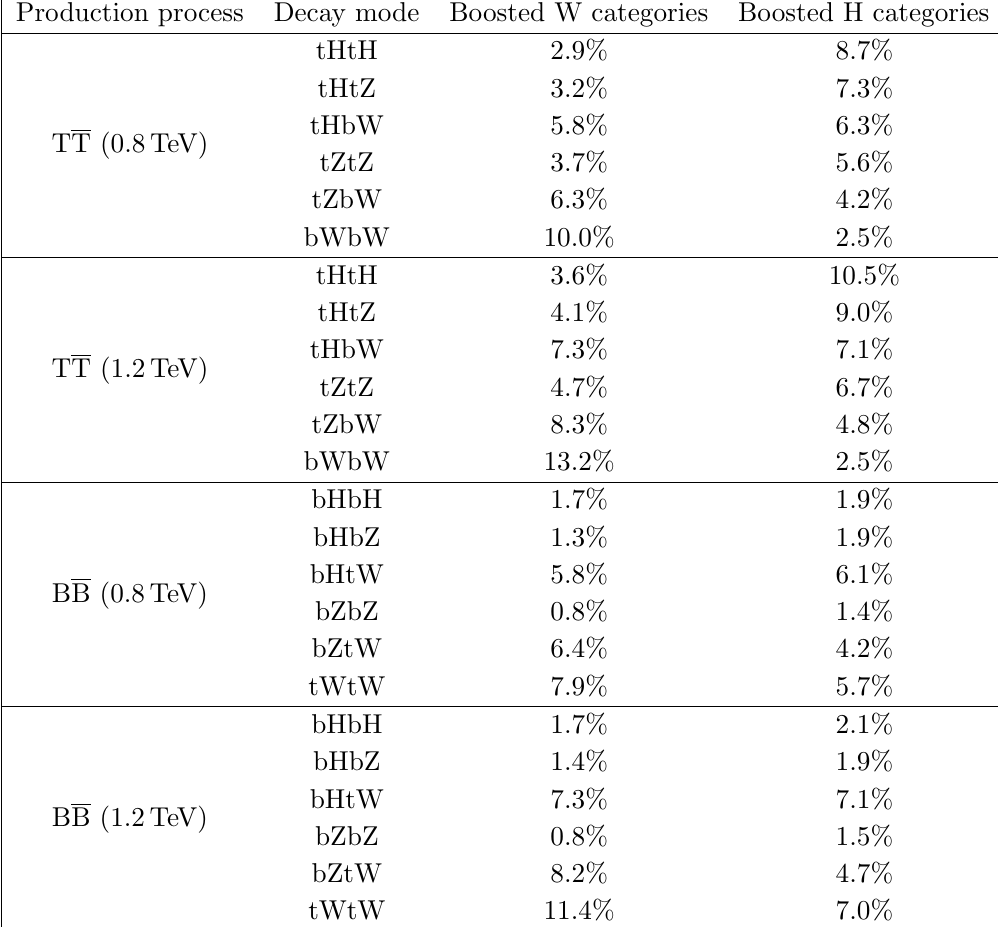
Table 3 . Signal e(cid:14)ciencies in the boosted W and boosted H event categories, split into the six possible (cid:12)nal states, of both TT and BB production for two illustrative mass points. E(cid:14)ciencies are calculated with respect to the expected number of events in the corresponding (cid:12)nal state before any selection. The relative uncertainty in the e(cid:14)ciencies after combining systematic and statistical uncertainties in the MC samples is about 8% in the boosted W categories and about 12% in the boosted H